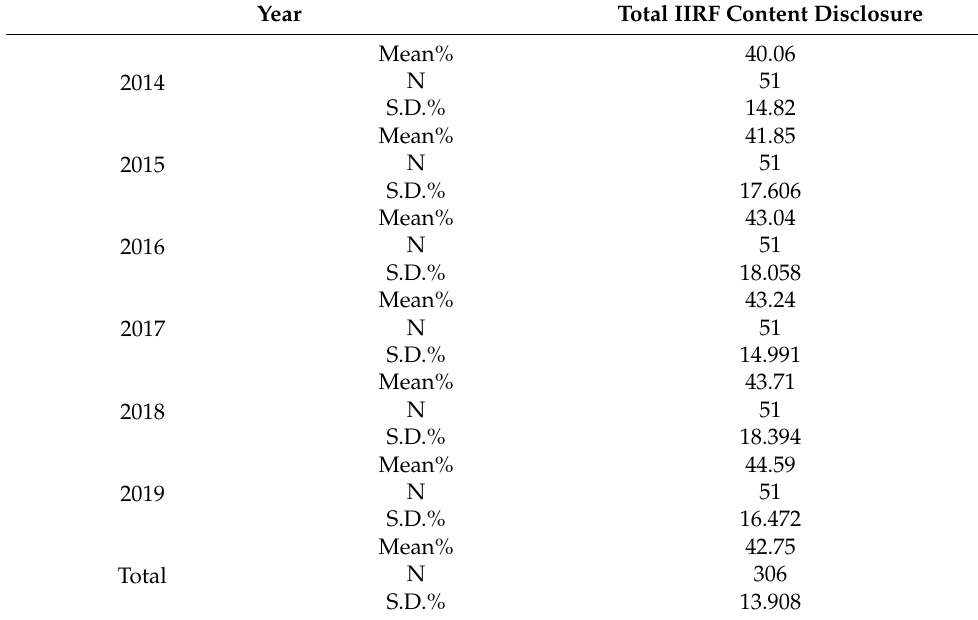
Table 4. Descriptive Analysis of the total yearly IIRF content disclosure.